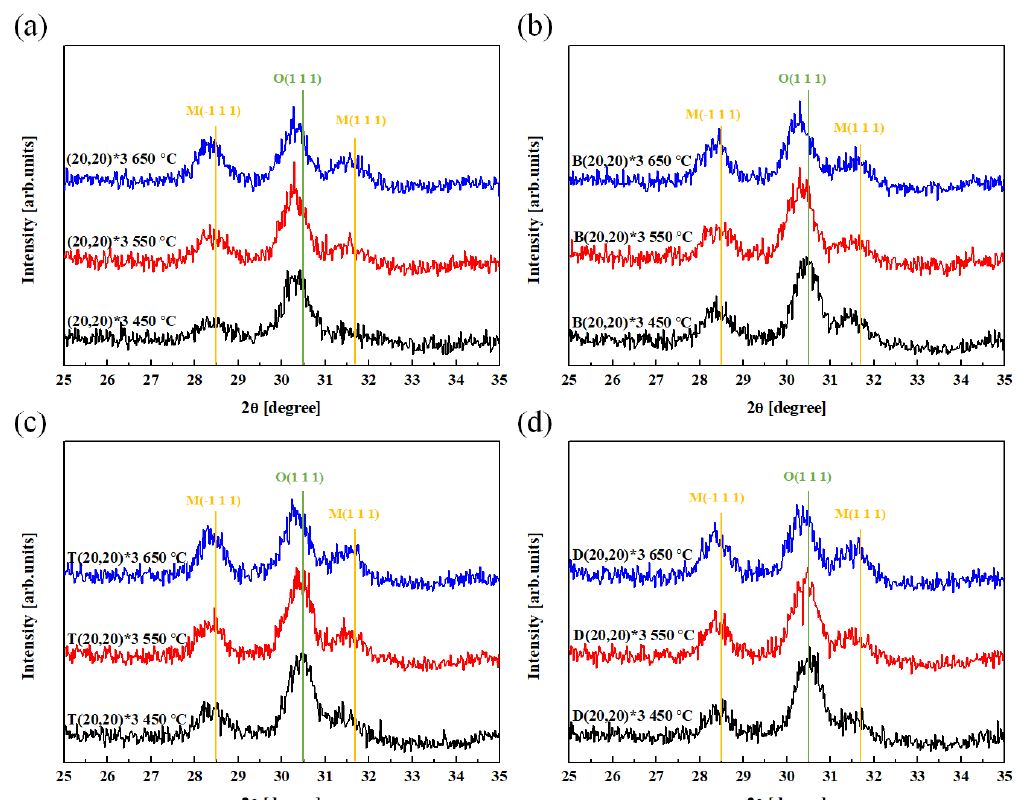
Figure 7. XRD patterns of the ( a ) (20,20)*3, ( b ) B(20,20)*3, ( c ) T(20,20)*3, and ( d ) D(20,20)*3 specimens as a function of the RTA temperature.